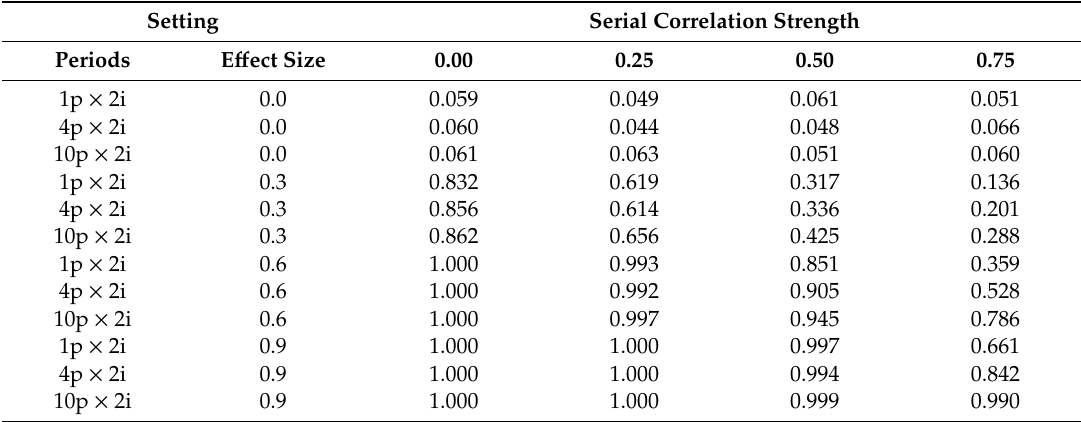
Table 3. Simulation study results investigating the power of N-of-1 designs as a function of e ff ect size (the di ff erence between the experimental intervention and comparator intervention in standard deviation units) and serial correlation